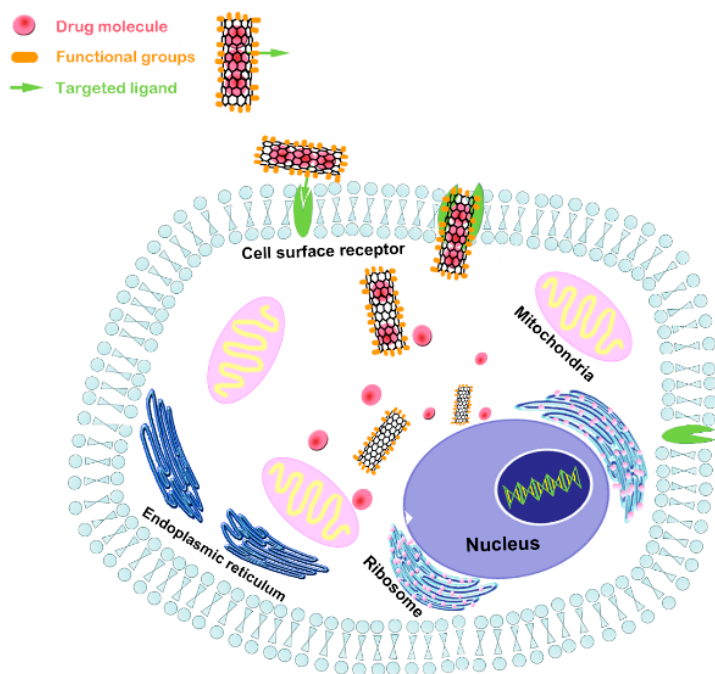
Figure 7. A CNT-based drug delivery system. Due to the poor cell penetration of many small molecules and an increasing number of large molecules, CNTs functionalized with a targeted ligand were able to penetrate cell membranes through an ion channel and transport-specific drug molecules into targeted cells.